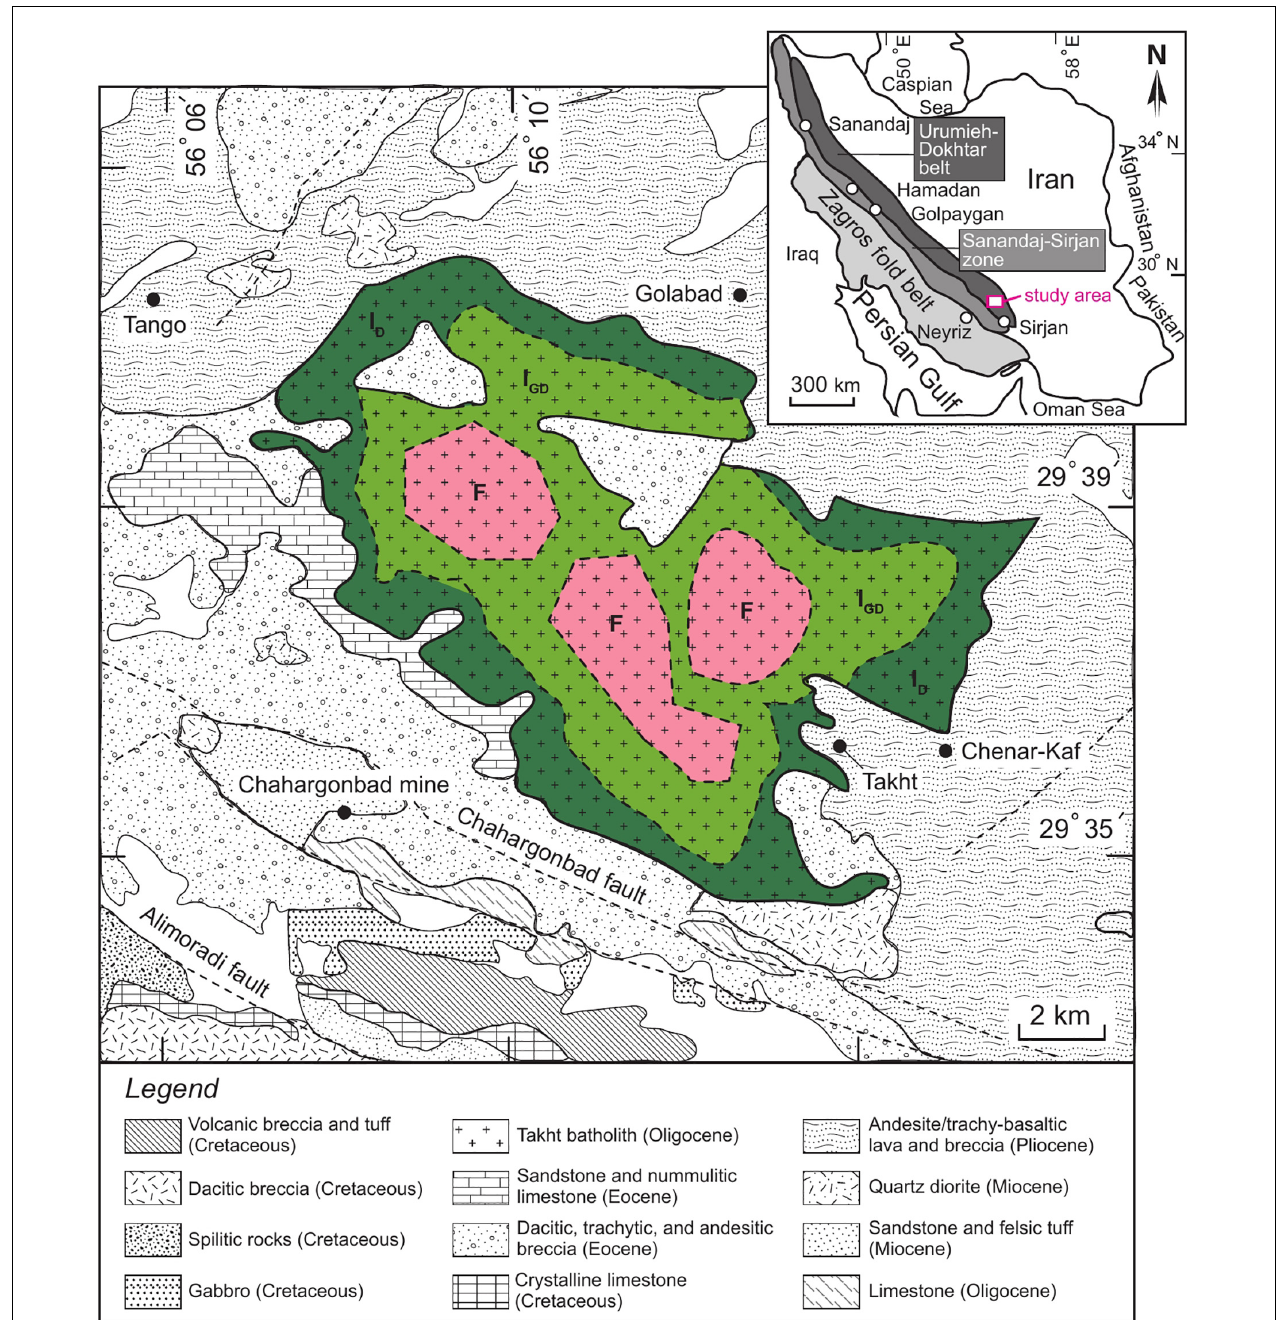
FIGURE 1 | Simplified geological sketch map showing the geology of the Takht batholith and adjacent areas, southeastern Iran (modified after Khan-Nazer and Emami, 1996). I D = intermediate unit dominated by diorite, I GD = intermediate unit dominated by granodiorite, F = felsic unit. Inset shows the main tectonic units of the Zagros orogen (Stöcklin, 1968).